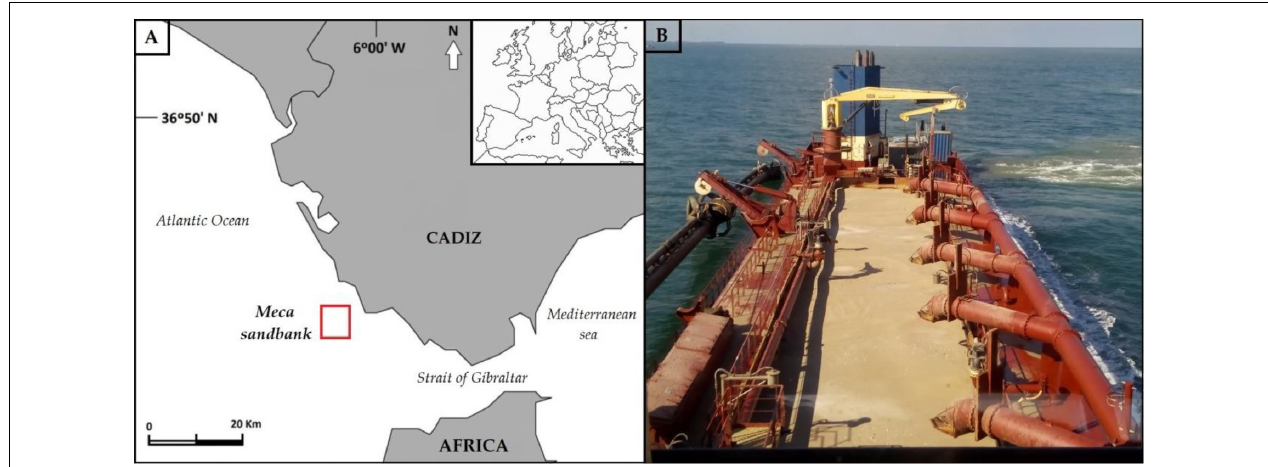
FIGURE 1 | (A) The Meca sandbank in the Gulf of Cadiz close to the Strait of Gibraltar (Spain, Europe). (B) The hopper of the trailing suction dredger where the samples were taken.